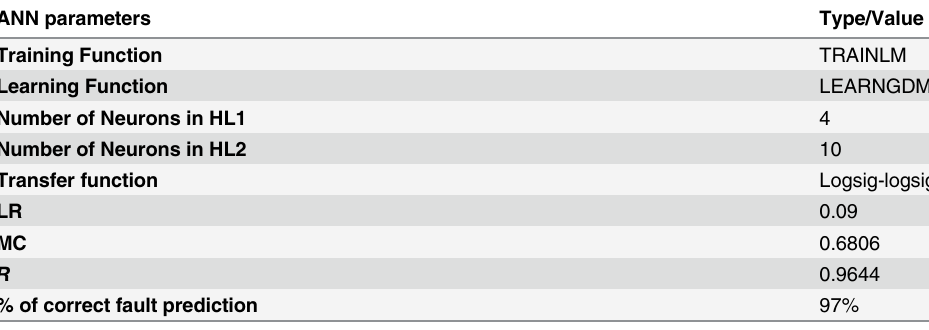
Table 6. Properties of the selected ANN combined with IPSO.